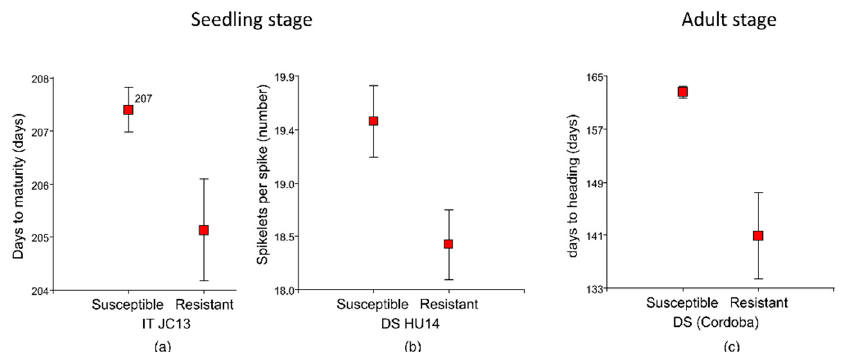
Figure 2. Differences in agronomic traits between leaf rust-resistant and susceptible landraces in ( a ) days to maturity for infection type (IT) to Jerez Califa 13 (JC13) at the seedling stage, ( b ) spikelet per spike for disease severity (DS) to Huesca 14 (HU14) at the seedling stage, and ( c ) days to heading for disease severity (DS) at adult stage in Cordoba locality.